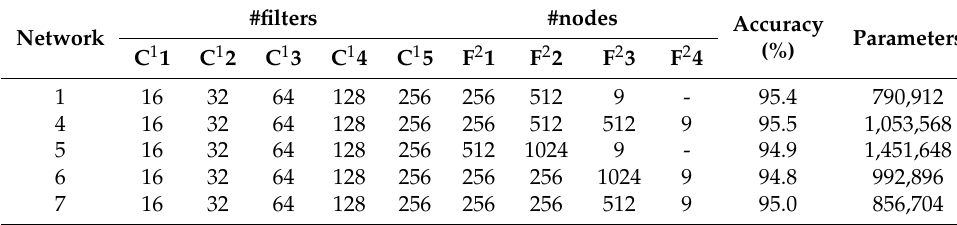
Table 3. Accuracy and parameters of BNNs based on CNNs with excellent performance.